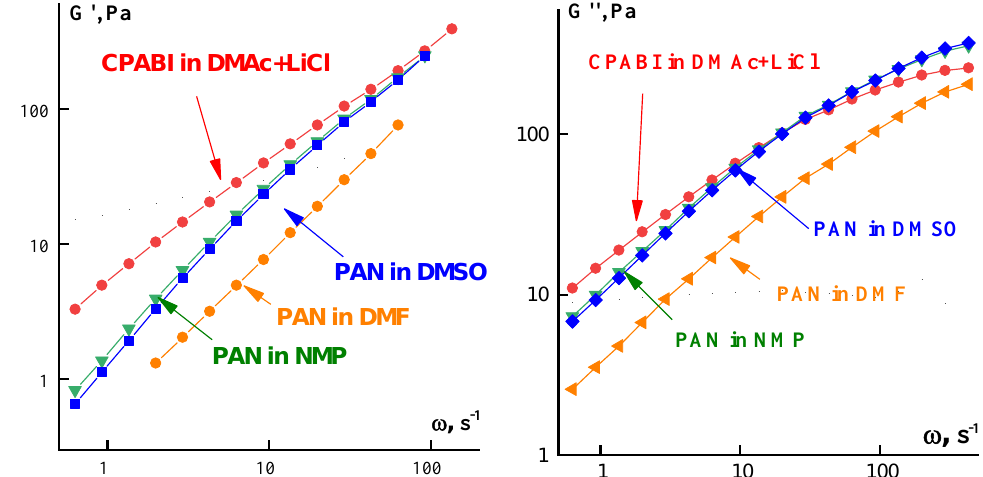
Figure 5. Frequency dependences of the storage ( left ) and the loss moduli ( right ) for PAN solutions in different solvents and the CPABI solution (shown at the curves).